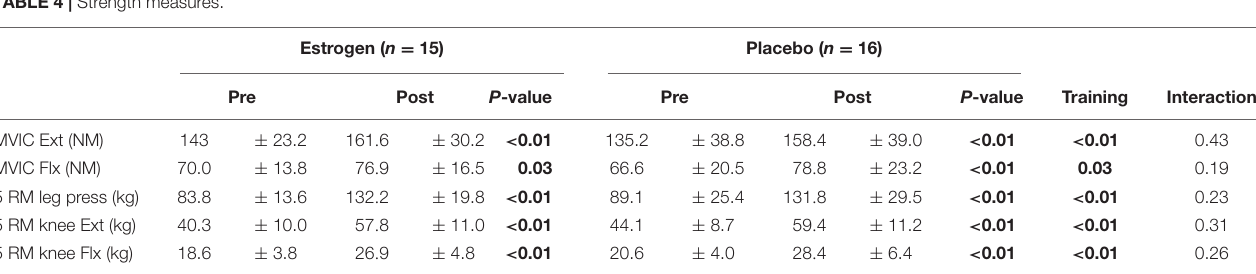
TABLE 4 | Strength